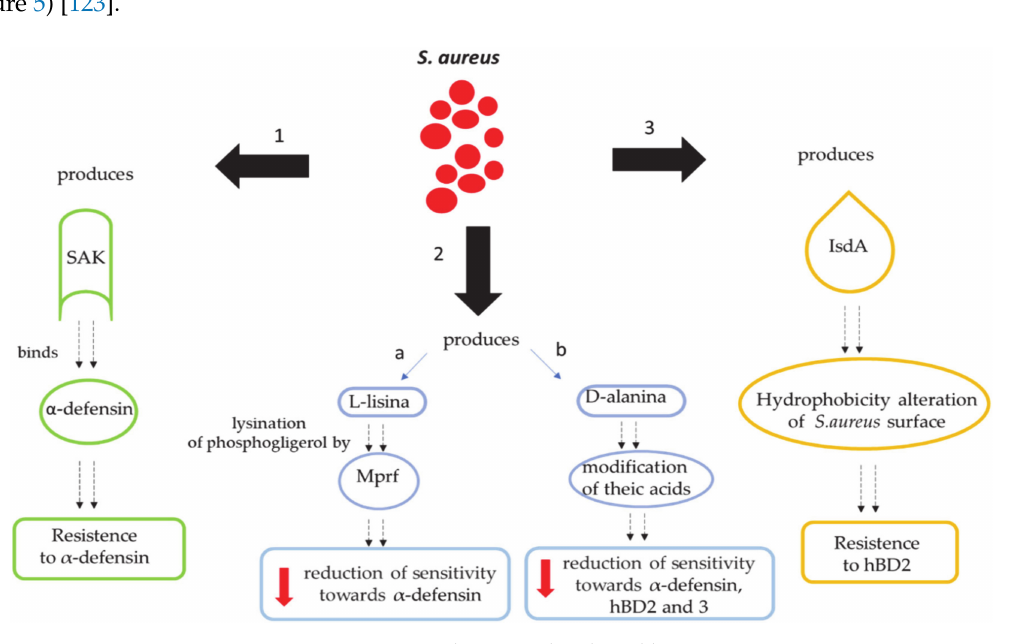
Figure 5. Evasion mechanisms developed by S. aureus